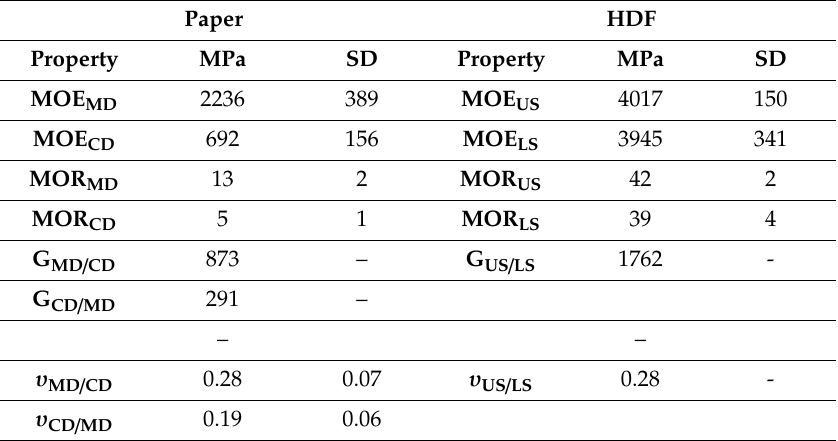
Table 2. Physical and mechanical properties of materials used in the study